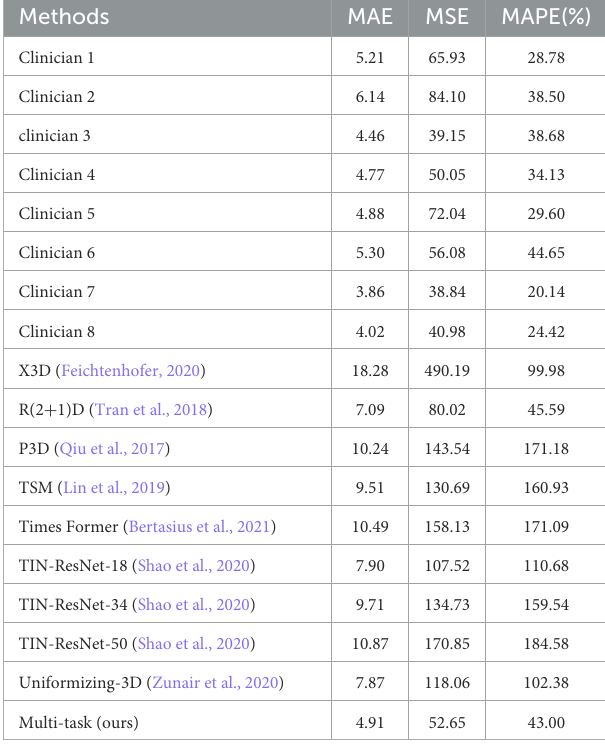
TABLE 1 Quantitative comparisons for the effectiveness of regression